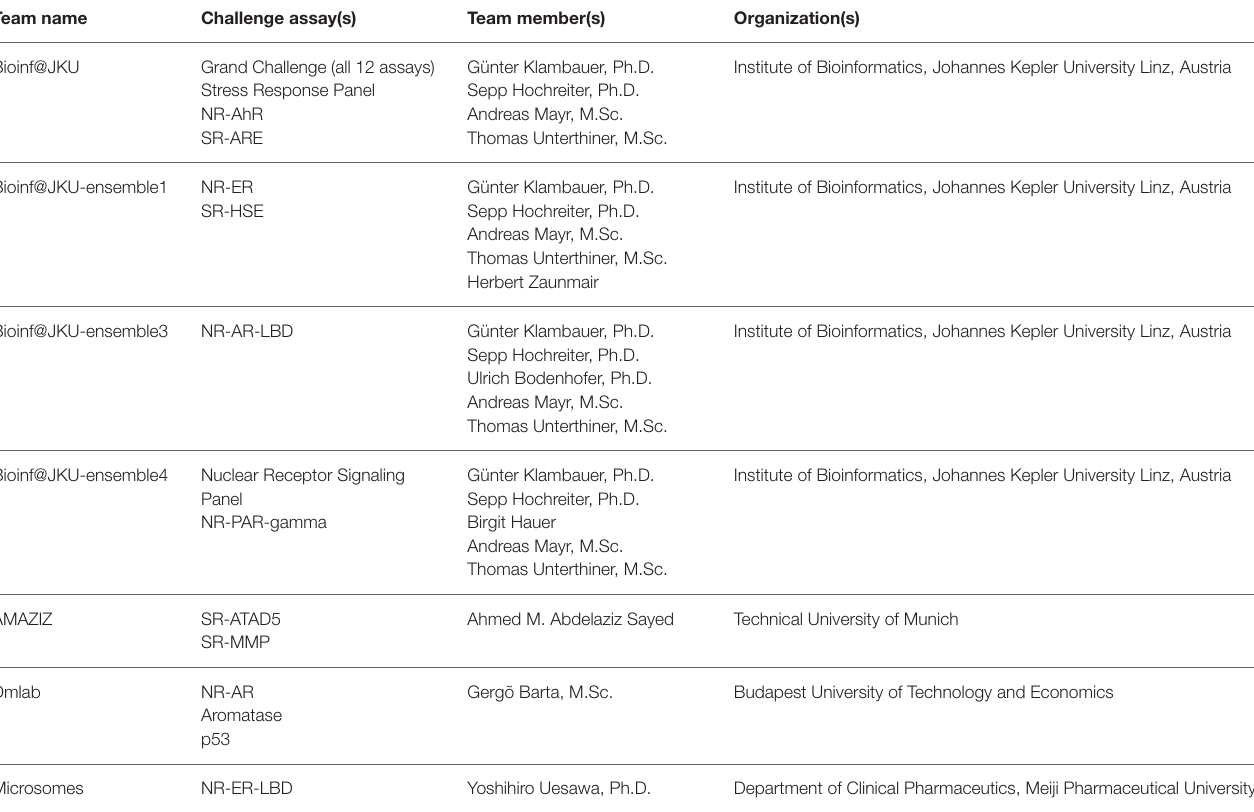
TABLE 2 | Tox21 challenge